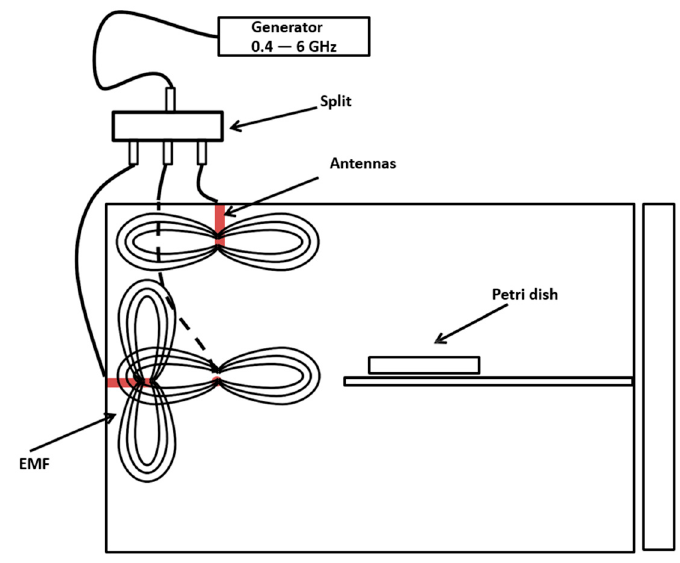
Figure 1. Schematic representation of the electromagnetic chamber.